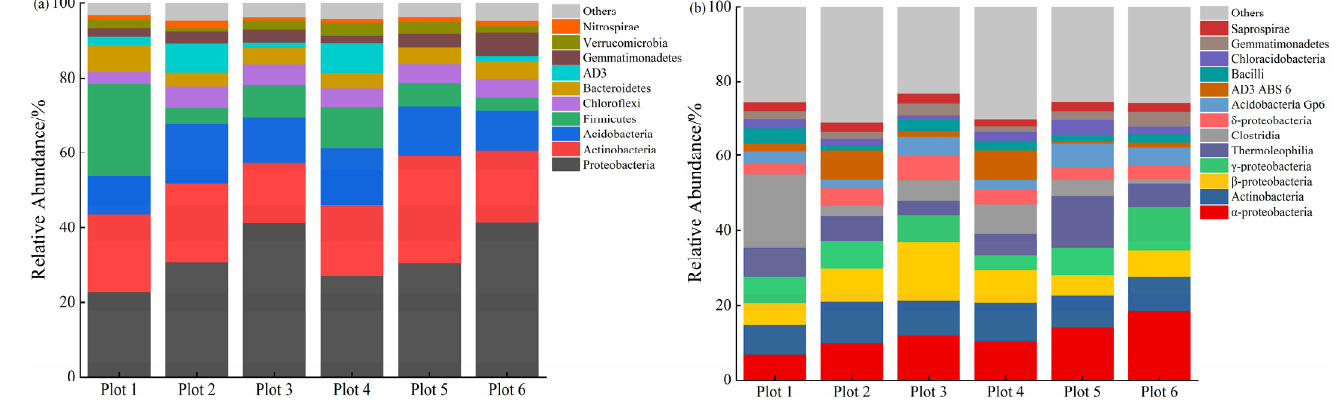
Figure 3. Bacterial community composition at the level of phylum ( a ) and class ( b ) in different plots. The phyla/classes with relative abundance greater than 1%/2% were defined as dominant phyla/classes, and sequences not classified to any taxonomy and phylogenetic groups accounting for ≤ 1%/2% of all classified sequences are summarized in the group “Others”.